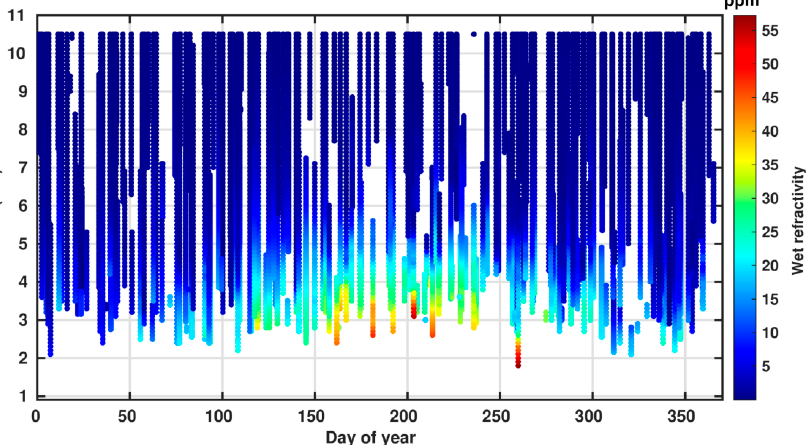
Figure 4. RO observations of training dataset in the patch (longitude 46.5 and latitude 39.5) with the minimum number of observations.